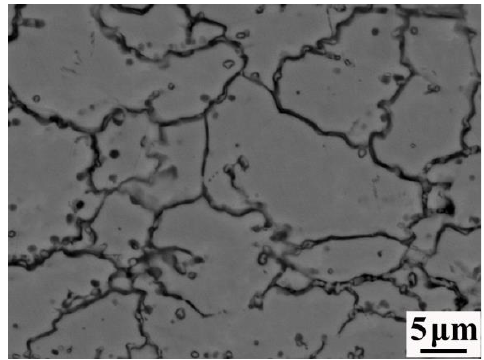
Figure 5. SEM image of the 55#/316L reinforcement stainless-steel side. Table 5. Point-sweep results for second-phase particles.